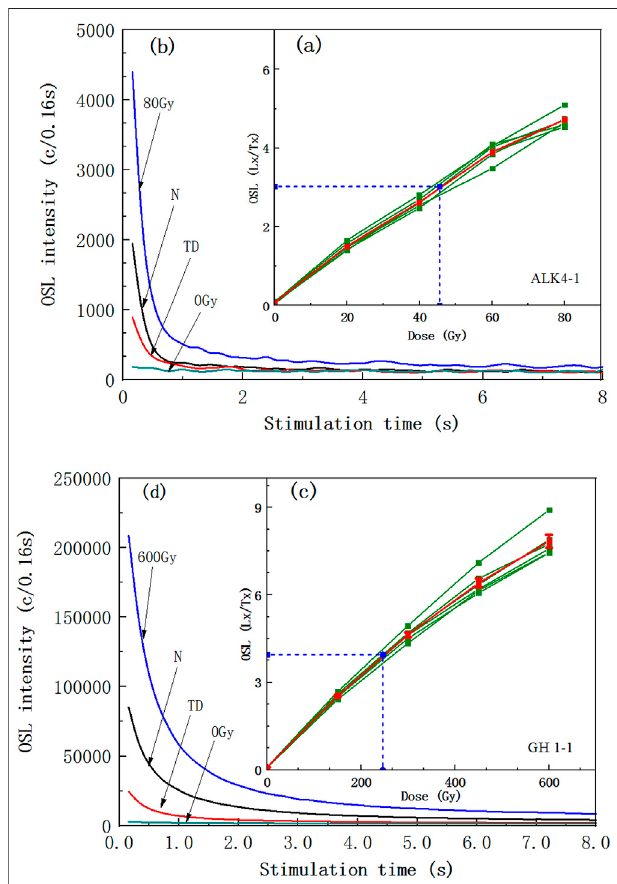
FIGURE3| LuminescencecharacteristicsofsamplesALK4-1andGH1- 1; (A) and (C) display the growth curves of six aliquots and the standard growth curve(SGC) (red lines), which istaken asthe average ofthe sixgrowth curves; (B) and (D) display the decay curves for the natural (N) and regenerative doses of R3, 0 Gy, and test dose (TD), respectively. The points (solid squares) de fi ning each individual growth curve are depicted with error bars. The horizontal and vertical blue dashed lines indicate the projection of the average of the sensitivity-corrected natural signals of the six aliquots onto the